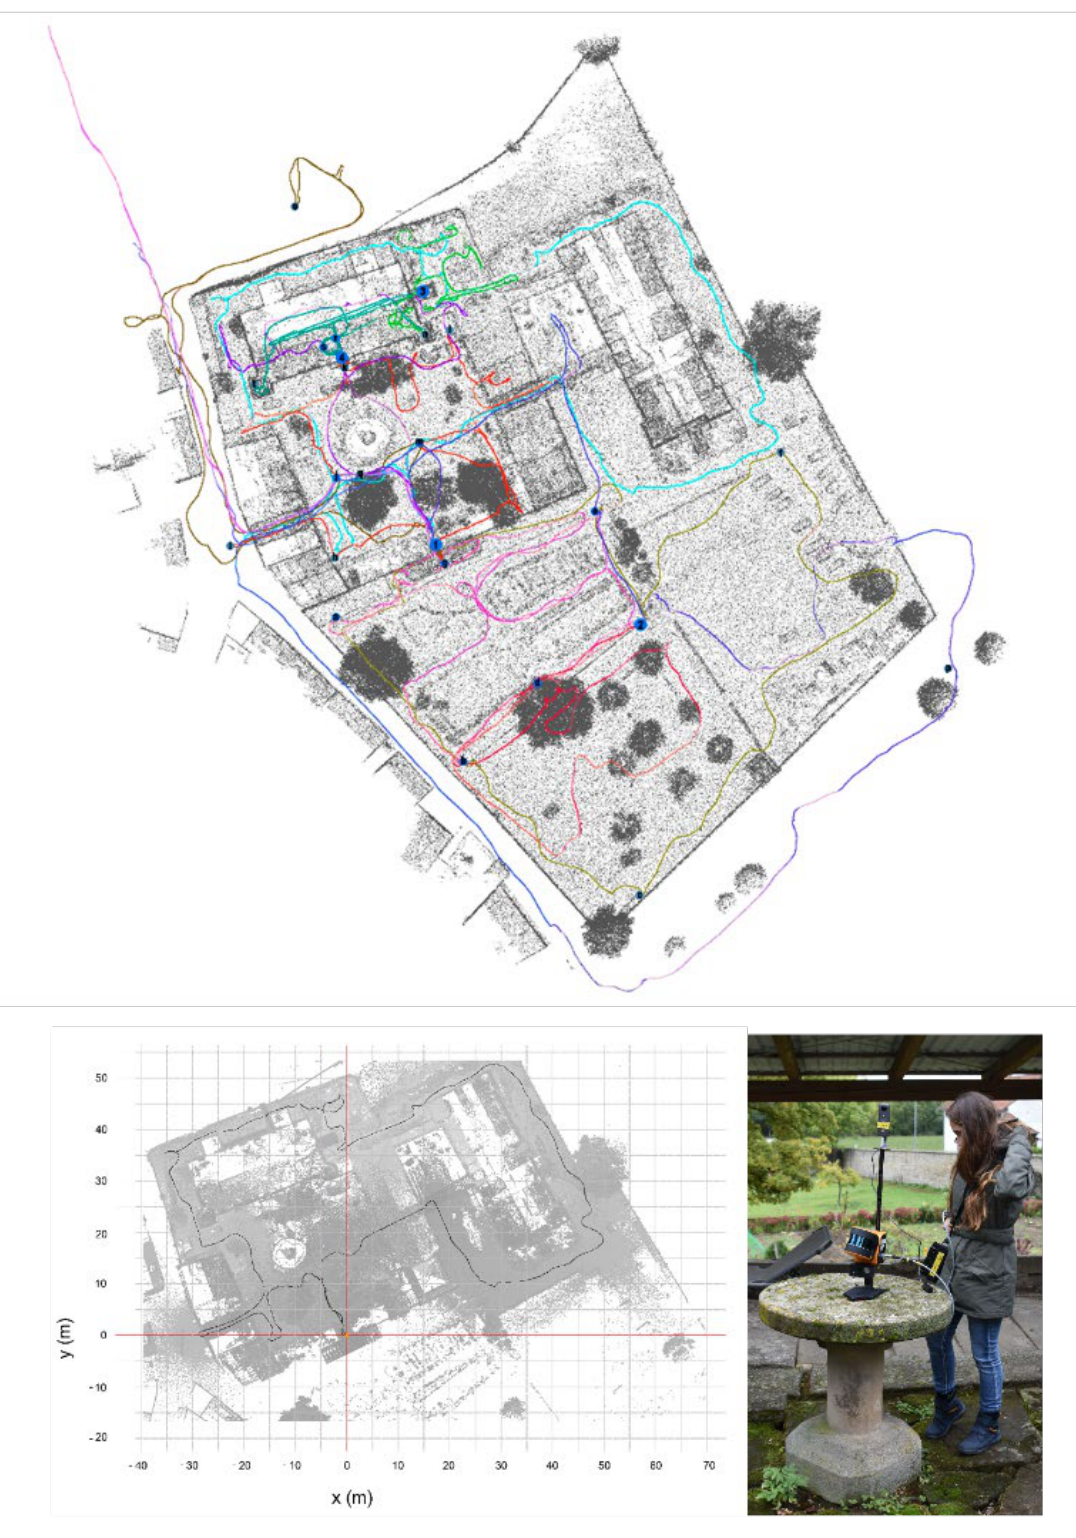
Figure 2: The data capture on the example of Mainstockheim. 12 loops were executed to cover the three different gardens (top) and register them correctly into a joint point cloud (bottom left). Starting points and reference points were defined at regular distances at landscape feature points (blue points on top image and example on top right